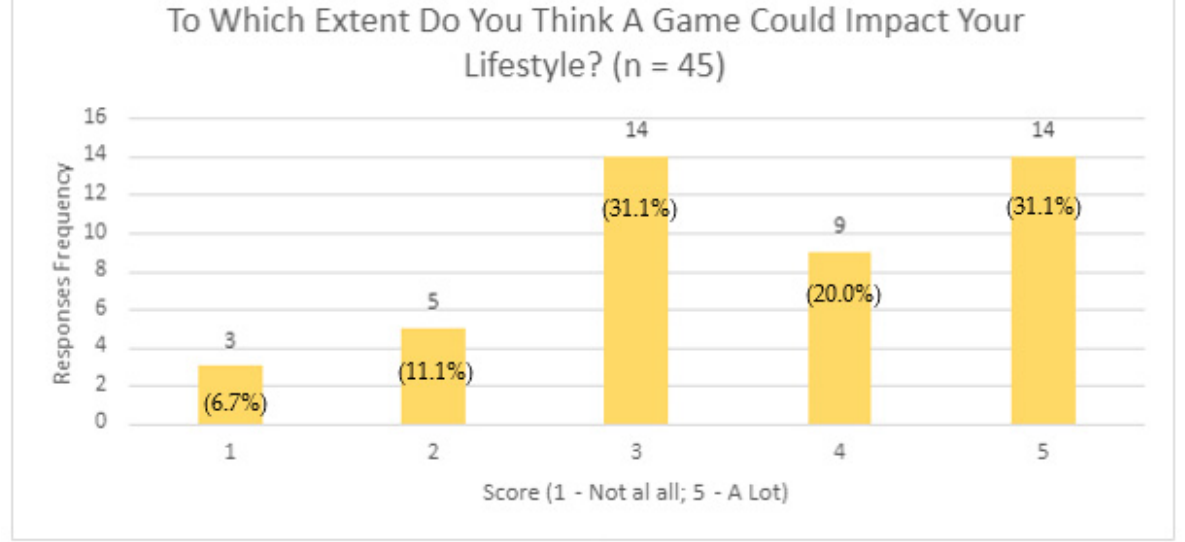
Figure 10. Expectation of the impact of a game.